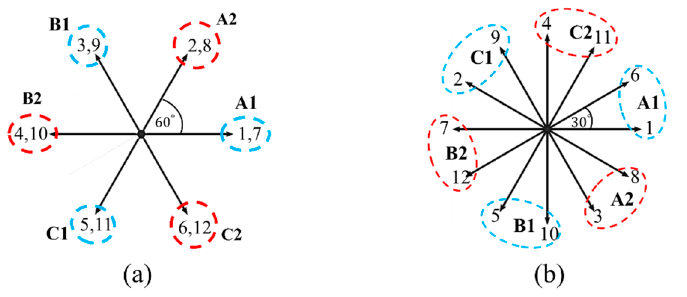
Figure 4 . Phase EMF phasors of the 6-phase V-shaped FSPM generators: ( a ) initial 12-stator/22-rotor structure; ( b ) 12-stator/19-rotor structure.